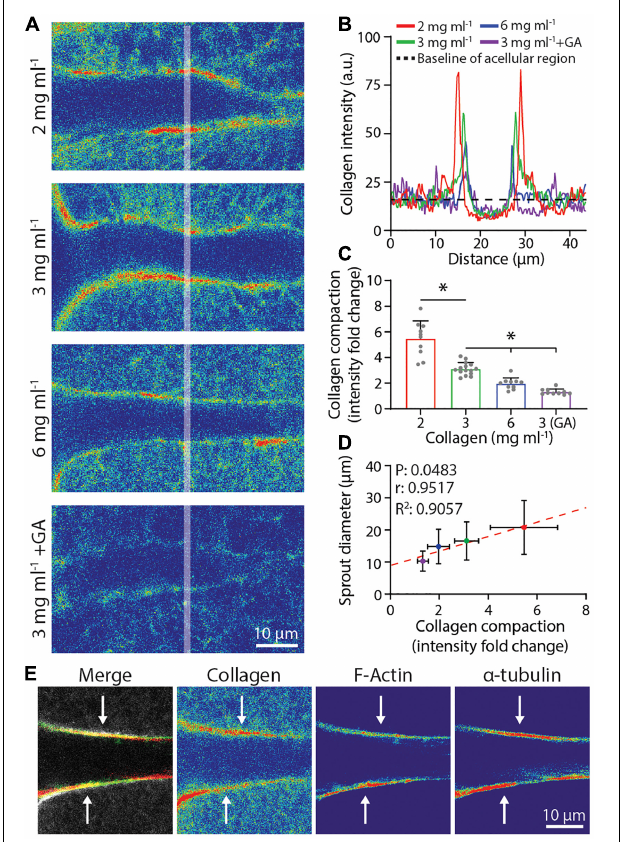
FIGURE 5 | Degree of collagen compaction adjacent to sprout stalk cells positively correlates with sprout diameter. (A) Representative images (individual z-slices) of fluorescently labeled collagen (shown as intensity heat map) surrounding sprout stalk cells in collagen matrices of varying density and stiffness. Sprouts were cultured for 3 days in 250 nM sphingosine 1-phosphate (S1P) and 50 ng ml − 1 phorbol 12-myristate 13-acetate (PMA) within collagen matrices of indicated density or with glutaraldehyde (GA) cross-linking. (B) Representative fluorescent collagen intensity profiles acquired along shaded white line indicated in panel (A) . 2 mg ml − 1 (red line), 3 mg ml − 1 (green line), 6 mg ml − 1 (blue line), and 3 mg ml − 1 with GA cross-linking (purple line) and average intensity of non-compacted, acellular areas (dashed black line). Intensity values of the non-compacted, acellular collagen regions were normalized to each other in panels (A,B) to compare collagen intensity fold change of compacted regions. (C,D) Quantification of collagen compaction and relationship between collagen compaction and sprout diameter, with red dashed line indicating a linear regression and statistical analysis performed by Pearson’s correlation. For collagen compaction: n ≥ 10 per condition. For each mean in panel (D) , n ≥ 10 for collagen compaction and n ≥ 70 for sprout diameter. (E) Representative images (individual z -slices) of sprout stalk region stained for F -actin (green) and α -tubulin (red) within fluorescently labeled collagen (gray). Individual channels visualized as intensity heat maps. All data presented as mean ± SD; *indicates a statistically significant comparison with P < 0.05 (one-way